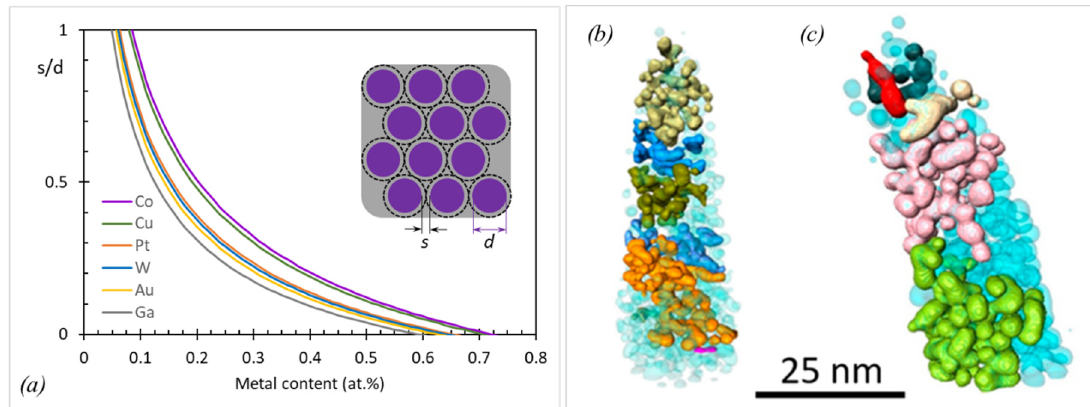
Figure 15. ( a ) The average nanoparticle distance s normalized to their size d versus the metal content for five metals. For s / d = 0, the full percolation metal threshold is reached. The inset shows the corresponding idealized close packed geometry of metal nanoparticles (purple) with a carbon shell (gray, dotted line). The carbon matrix density was set to 2 g / cm 3 . ( b ) and ( c ) show 3D reconstructions from Pt-C nanopillars, which were derived from high-resolution TEM tomography. ( b ) shows the as-grown FEBID with 30 keV / 21 pA, with large Pt nanocrystals becoming evident and revealing slightly percolated characteristics, as indicated by the di ff erent colors. After high-dose e-beam curing at 30 keV / 150 pA, the grain growth (average by 25 rel.%) is clearly evident, while the partial percolation characteristics remain, as shown by the di ff erent colors in ( c ). Images have been adapted from reference [102] .